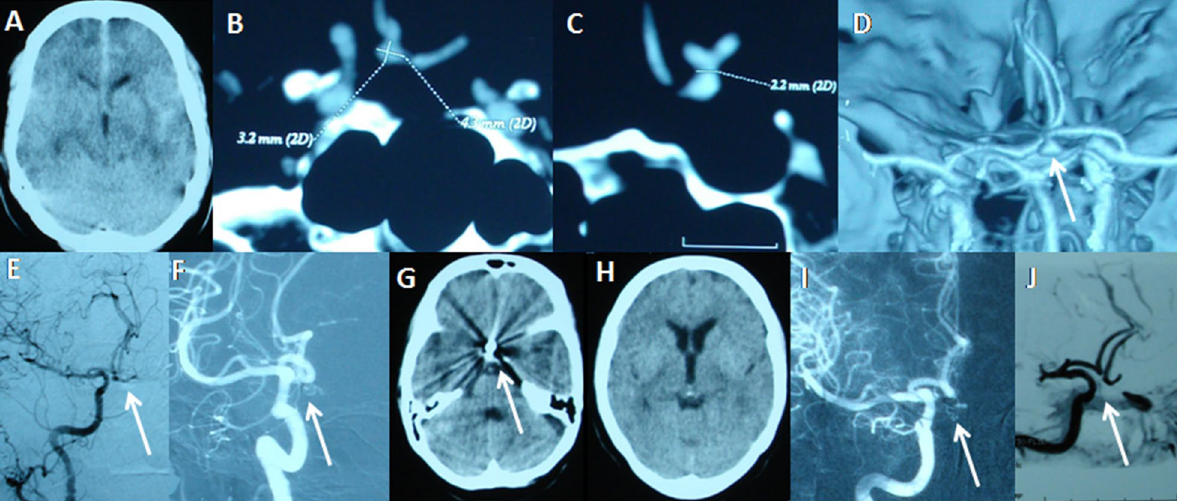
Fig. 1 LA case 41-year-old lady presented to our hospital by SAH from ruptured AcomA aneurysm H&H showed diffuse SAH with main cast at the anterior interhemispheric fissure, B , C preoperative CT angiogram with 2D showed small narrow neck AcomA aneurysm directed anteroinferiorly with the following dimensions (3.2 3D reformate demonstrating the shape and direction of the AcomA aneurysm, E , F preoperative and completion (End of procedure) DSA A–P view showing the AcomA aneurysm before and after complete obliteration (CO) under LA, G , H post-coiling axial CT brain showed the metallic coil artifact with no post-procedural sequelae, I , J 1-year postprocedural FU DSA, MRA that showed stable complete obliteration of the aneurysm